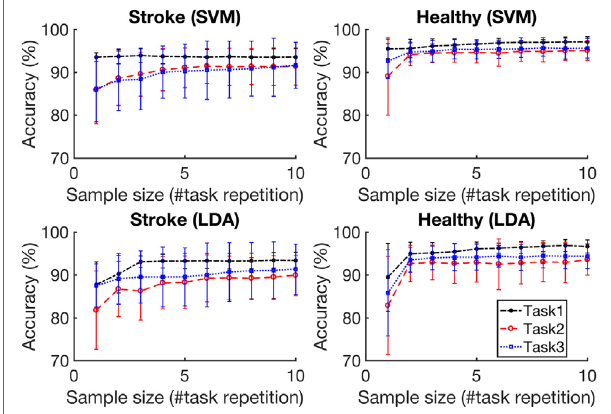
FigUre 5 | Average classification accuracy vs. training set size. The accuracies were averaged across the three tasks and eight subjects for each population, for training set sizes ranging from 1 repetition to 10 repetitions. The error bars represent 1